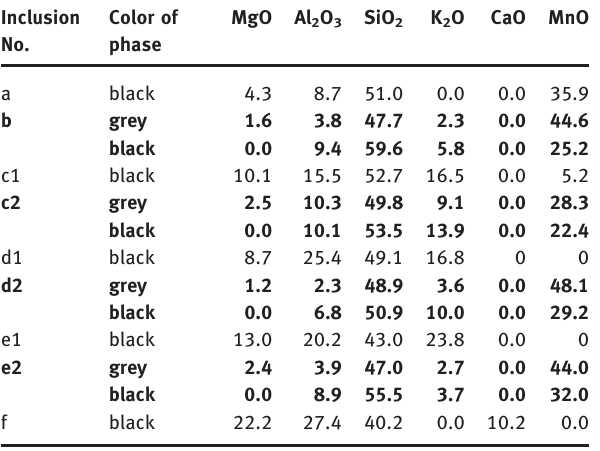
Table 5: Chemical compositions of typical inclusions corresponding to Figure 11/mass%. Inclusion